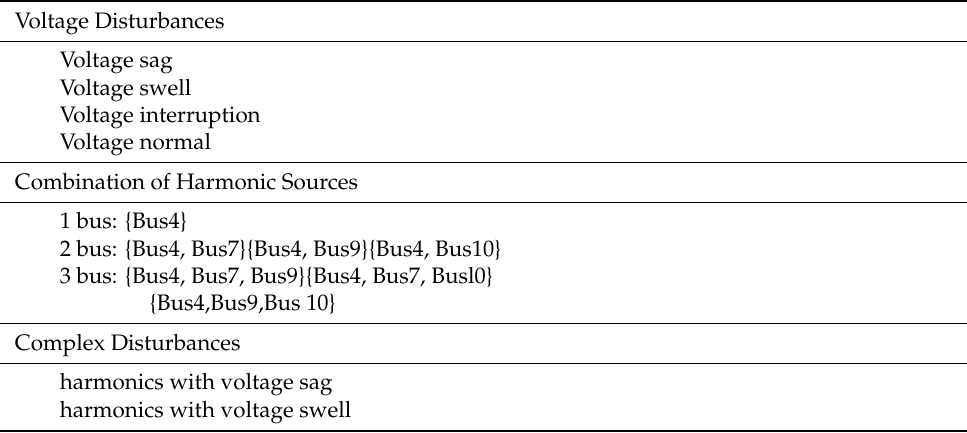
Table 2. Disturbing events for training at Obs-4.